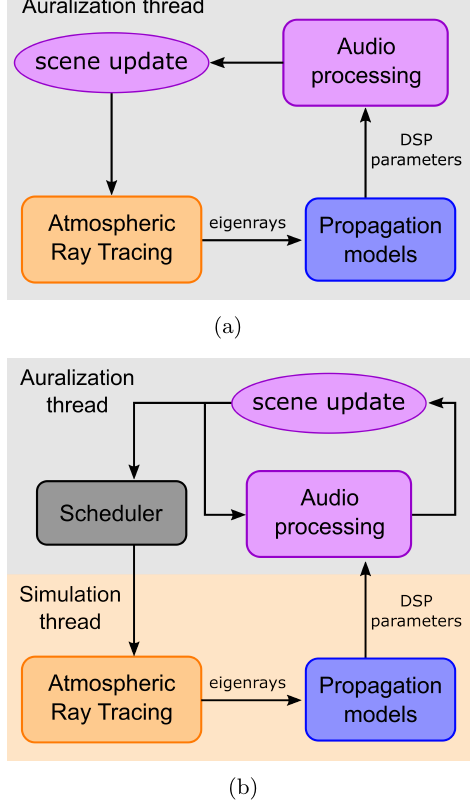
Figure 10. Simpli fi ed diagrams of integrating the Atmospheric Ray Tracing framework into an auralization process. (a) Sequen- tial auralization approach. (b) Simulating in separate